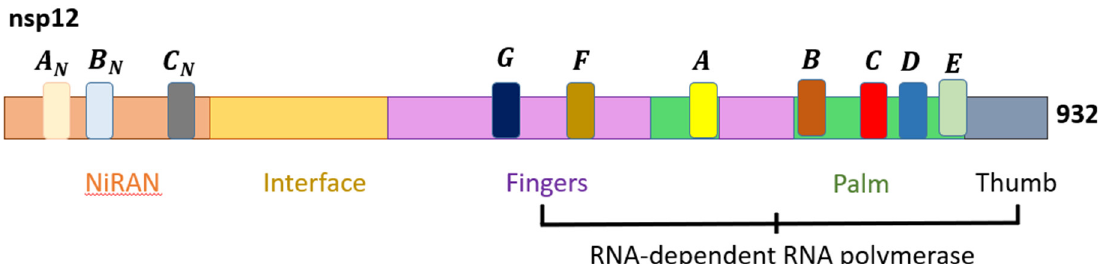
Figure 2. The domain structure of SARS-CoV-2 NSP12 that comprises the nidovirus RdRp-associ- ated nucleotidyltransferase (NiRAN), interface, and RdRp domains [47]. nucleotidyltransferase (NiRAN), interface, and RdRp domains